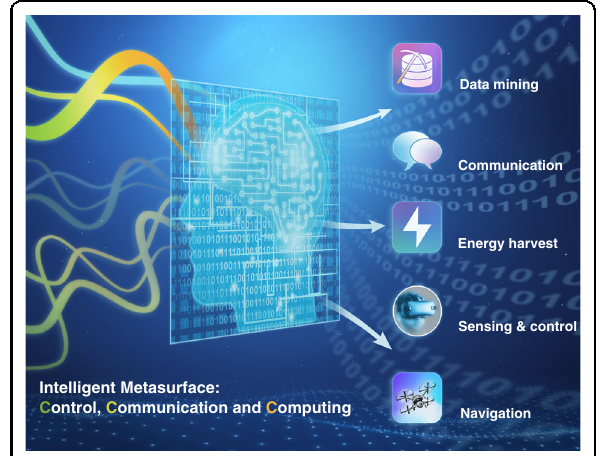
Fig. 1 Future applications for intelligent